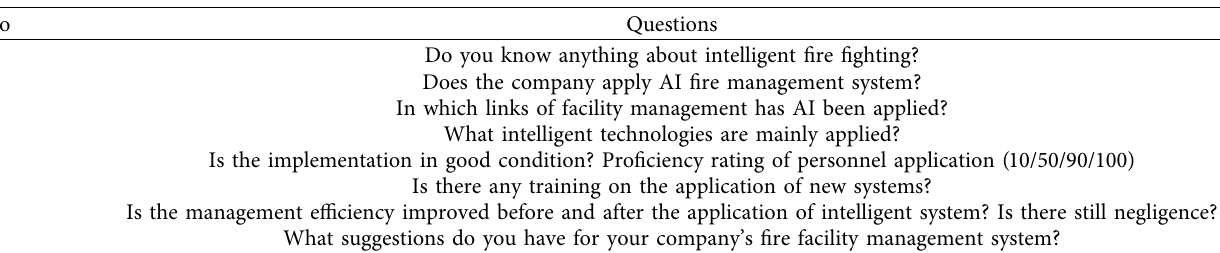
Table 19: Interview survey on existing intelligent fre-fghting system.